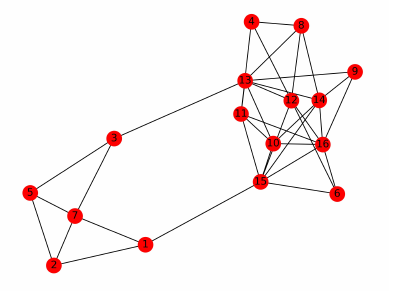
Figure 2. Example of another undirected network.